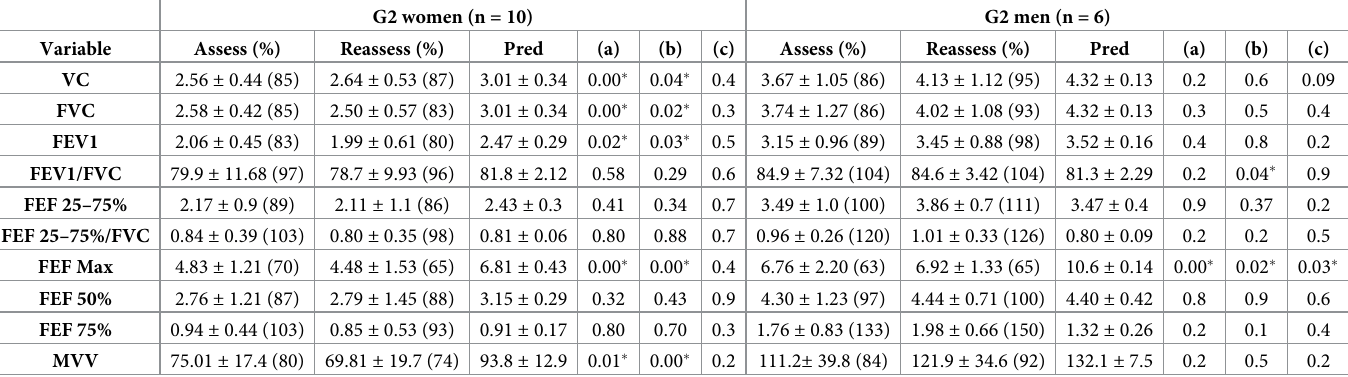
Table 4. Comparison of pulmonary lung function of G2 individuals with lung injury (n = 16) at chest CT (2014–2019). G2 women (n = 10) G2 men (n =